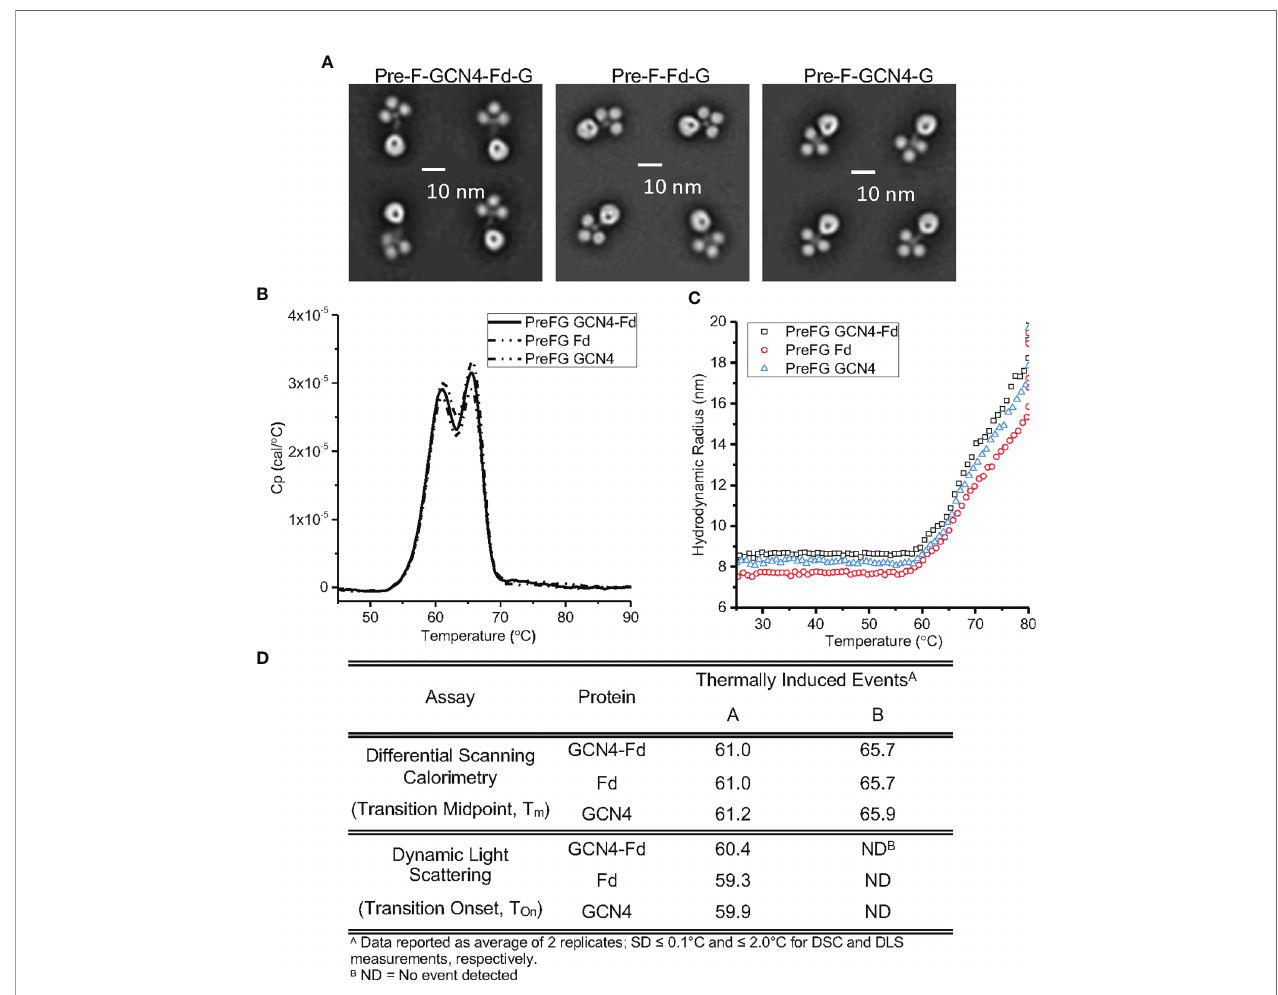
FIGURE 4 | Biophysical Properties of Pre-F/G Chimeric Proteins with Different Trimerization Domains. (A) Negative-stain EM analysis of NiV pre-F/G chimeric proteins. (B, C) Thermodynamic and colloidal stability assessment of pre-F/G chimeric trimerization domains assessed by (B) differential scanning calorimetry (DSC) and (C) dynamic light scattering (DLS). (D) Summary of DSC and DLS